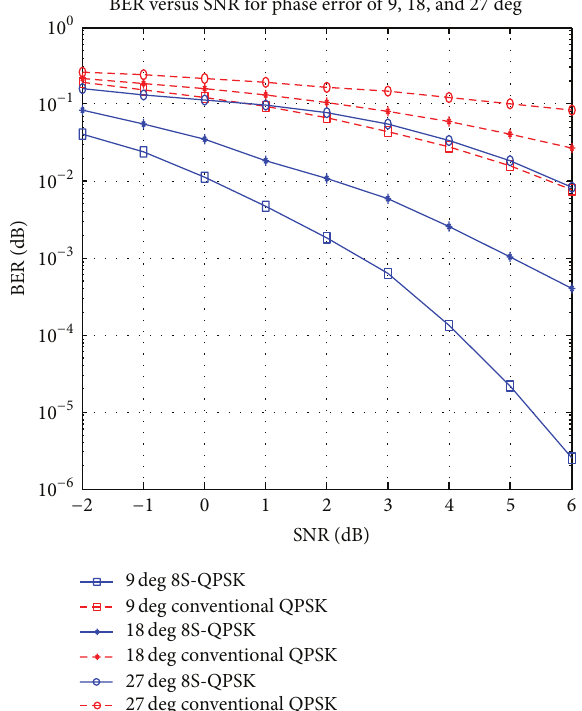
Figure 5: Performance comparison of 8S-QPSK and conventional QPSK signal with phase errors of 9 ∘ , 18 ∘ , and 27 ∘